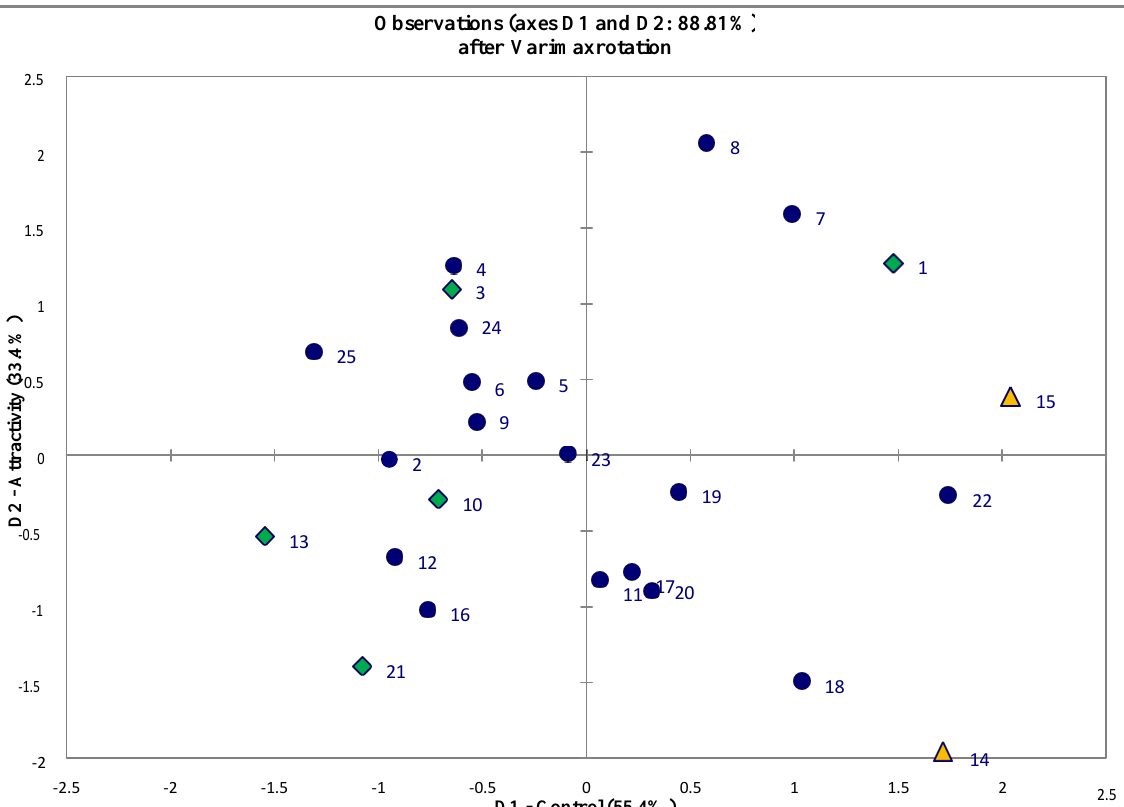
Figure 2. The position of players by twodimensions